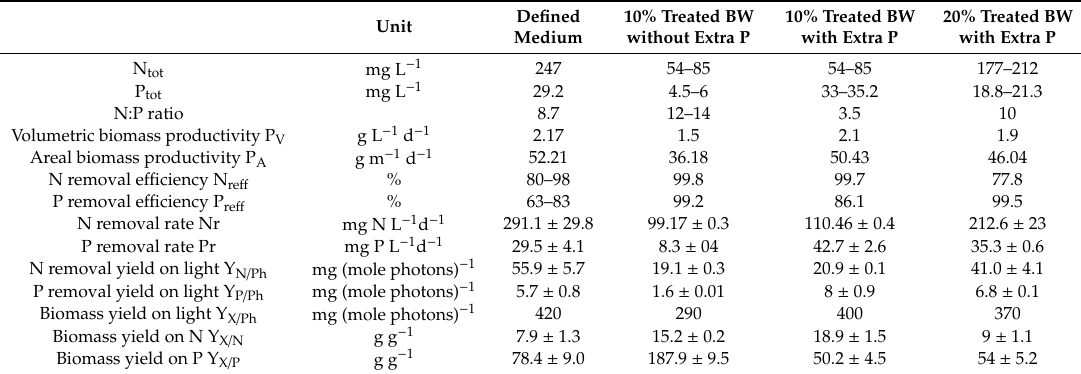
Table 2. The average ( ± standard deviation) of nutrient removal rates, the nutrient yield on light, biomass yield on light, and biomass yield on a substrate (N and P) on the defined medium as compared to the treated blackwater